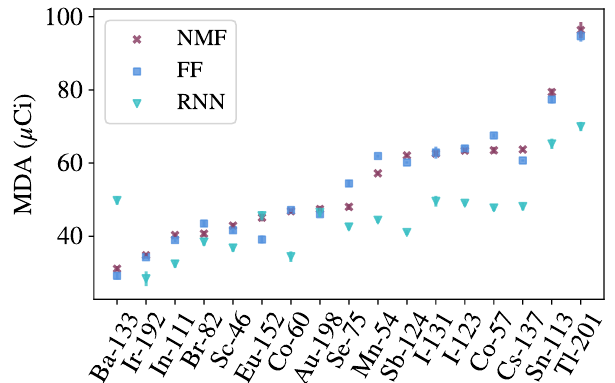
Figure 8. Comparison of the three methods evaluated on the test set: NMF-based identification, a feedforward network (FF), and an RNN-based identification method. Sources are sorted in ascending order MDA for the baseline NMF method. A total FAR of approximately 1/8 h − 1 across all sources is achieved by setting a threshold for each source individually set based on an effective FAR of 1/(8 × 17) h − 1 . The RNN is seen to generally provide an improvement over its feedforward counterpart, though there are a few notable examples, such as 133 Ba. Note that there is an overlap of points between NMF and FF for 60 Co, 123 I, 131 I, and 192